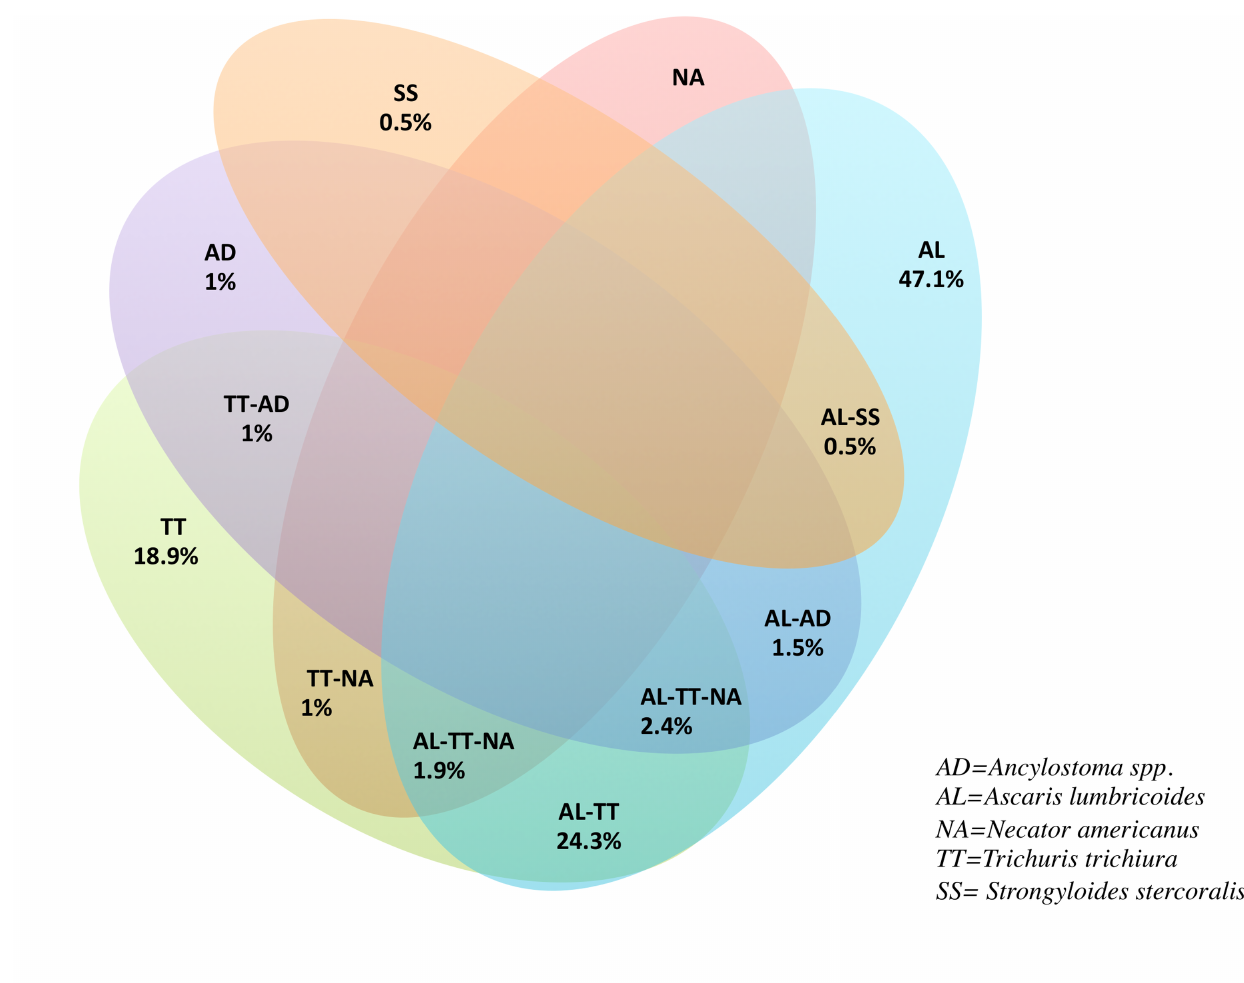
Fig 2. Venn diagram detailing the specific division of STH co-infections determined by